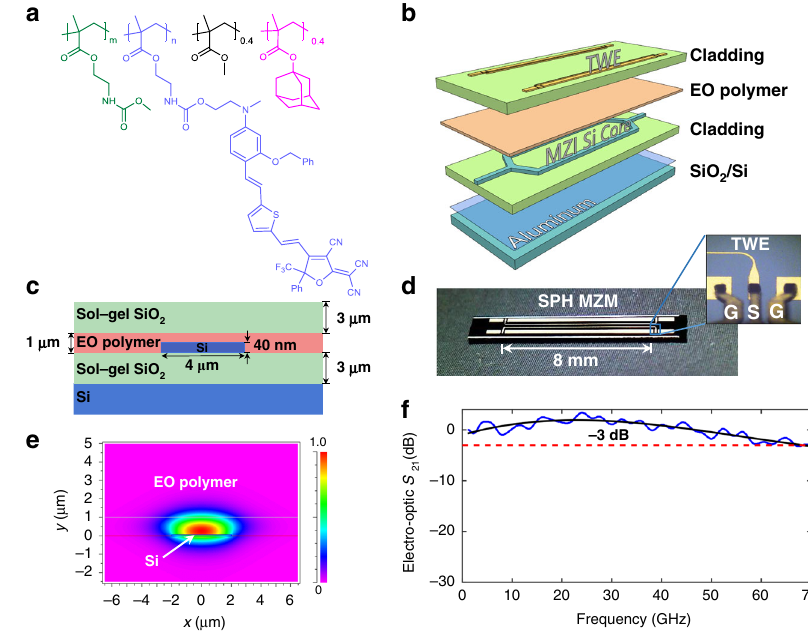
Fig. 1 Silicon-polymer hybrid (SPH) modulators. a Molecular structure of the synthesized side-chain EO polymer. b Schematic diagram of the fabricated SPH modulator by layers. c Cross-sectional view of the phase shifter section of the SPH modulator. d Top view photograph of a fabricated SPH modulator chip. Inset: close-up micrograph of the electrode section of the device with an RF probe. The ground contacts penetrate to the bottom electrode of the device. e Numerically simulated optical fi eld distribution in the cross-section of the modulator. f Measured EO bandwidth ( S 21 parameter) of the SPH modulator. The measured 3-dB bandwidth of the SPH modulator is around 68 GHz. The solid black line represents the fi tted